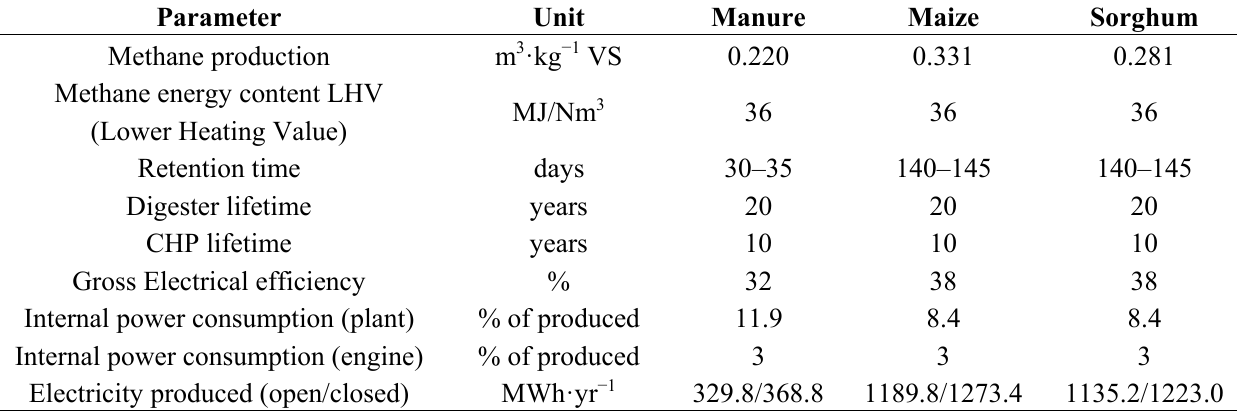
Table 1. Summary of the main technical characteristics of the biogas plant